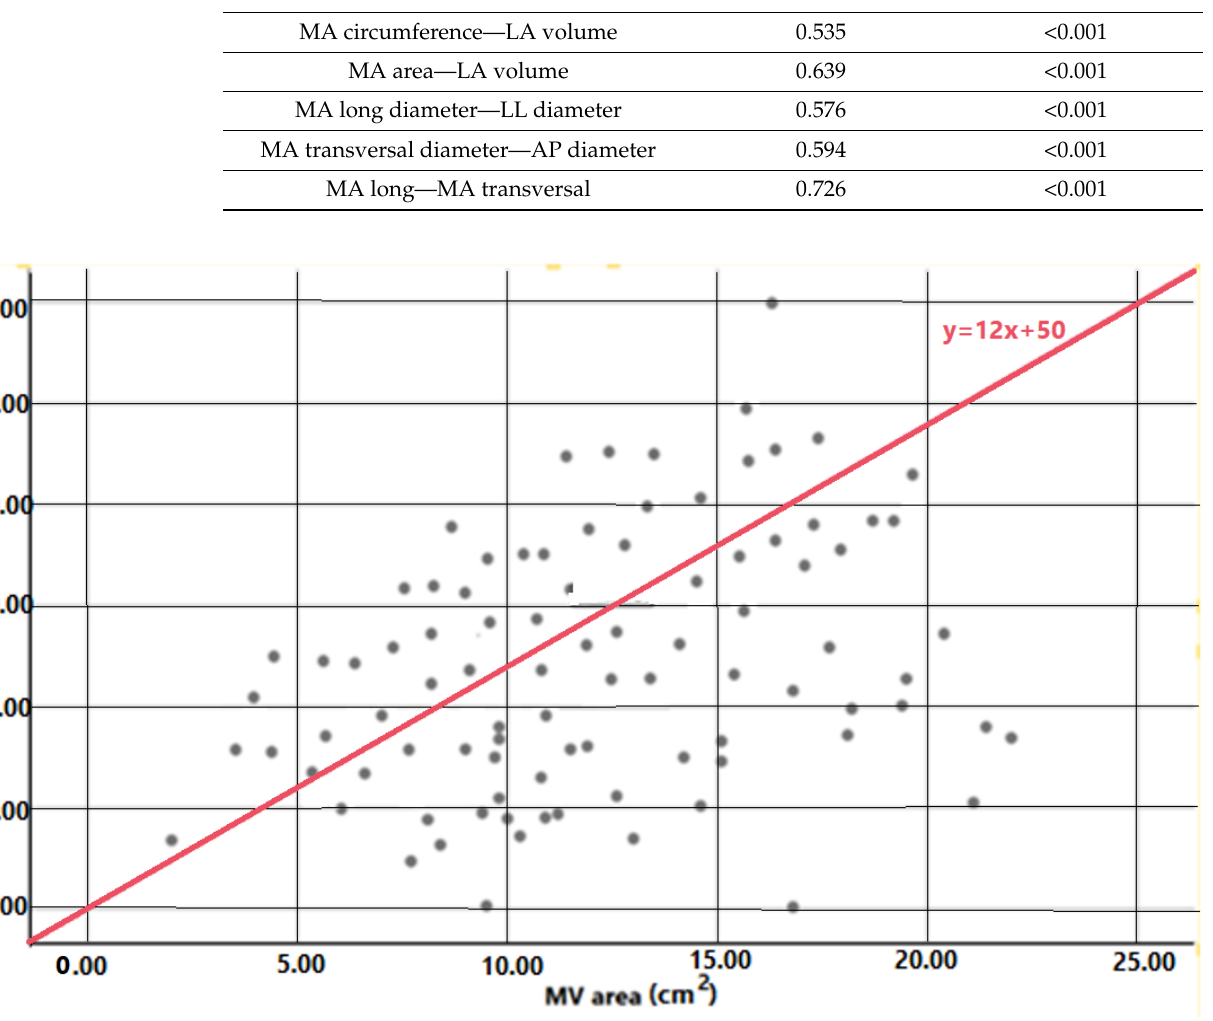
Figure 3. Simple regression analysis between mitral valve area and left atrial volume in patients with catheter ablation of atrial fibrillation. Reference line from regression equation is depicted in the image (LA volume = 12 × MV area + 50 mL).